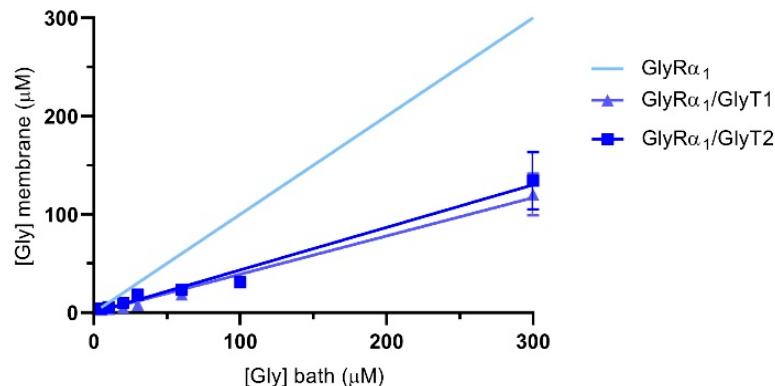
Figure 7. Glycine concentration sensed at the membrane of oocytes expressing GlyR α 1 / GlyTs. Since currents are reduced under fast-flow conditions, the glycine concentration at the membrane under fast-flow conditions in co-expressed oocytes was estimated by substituting EC 50 and Hill coefficient values from cells expressing only GlyR α 1 , and current values from GlyR α 1 / GlyT1 or GlyR α 1 / GlyT2 co-expressed oocytes into the reversed Hill equation. The light blue line represents the glycine concentration sensed at the membrane when no transporters are present. Curves for GlyR α 1 / GlyT1 and GlyR α 1 / GlyT2 were fit by linear regression and values represent mean ± SEM, n ≥ 5.